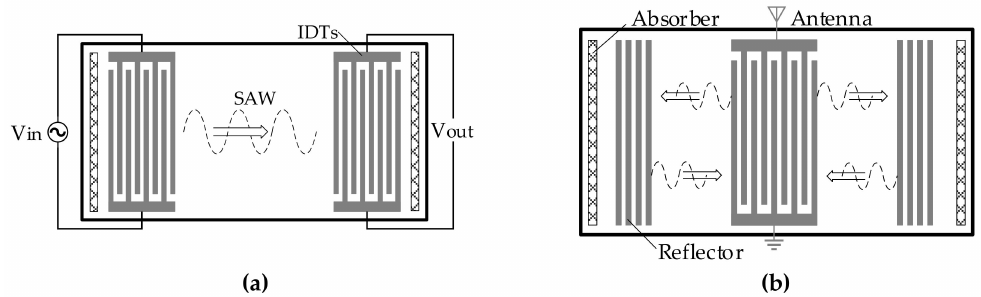
Figure 1. Structure of a SAW unit: ( a ) delay line; ( b ) single port